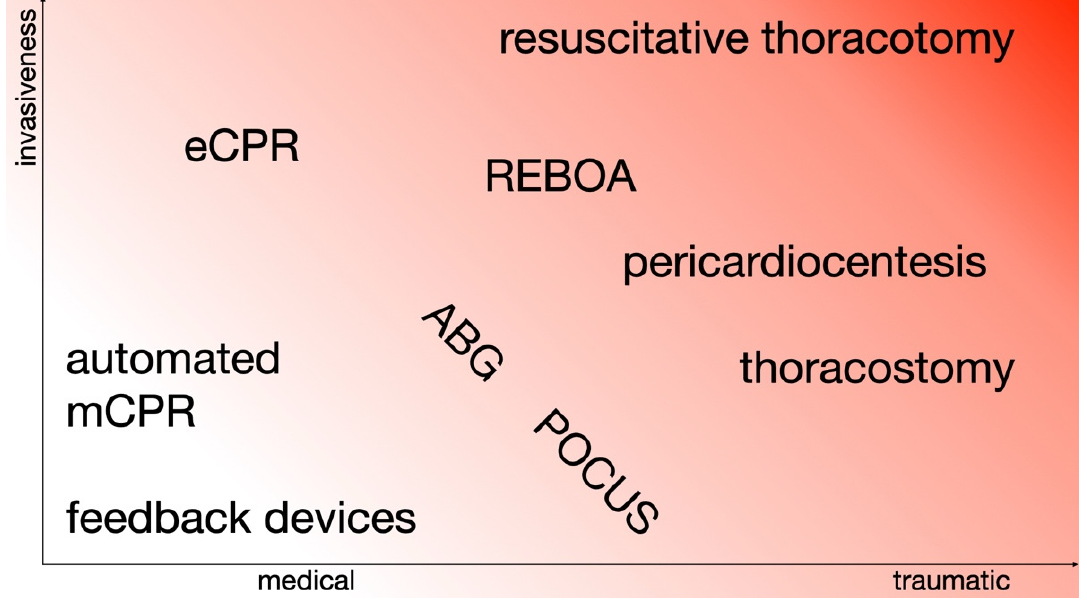
Figure 6. Advanced and invasive techniques may be considered in medical and traumatic car- diac arrest. Abbreviations: CPR = cardiopulmonary resuscitation, eCPR = extracorporeal CPR, mCPR = (automated) mechanical CPR, REBOA = resuscitative endovascular balloon occlusion of the aorta, ABG = arterial blood gas, and POCUS = point-of-care